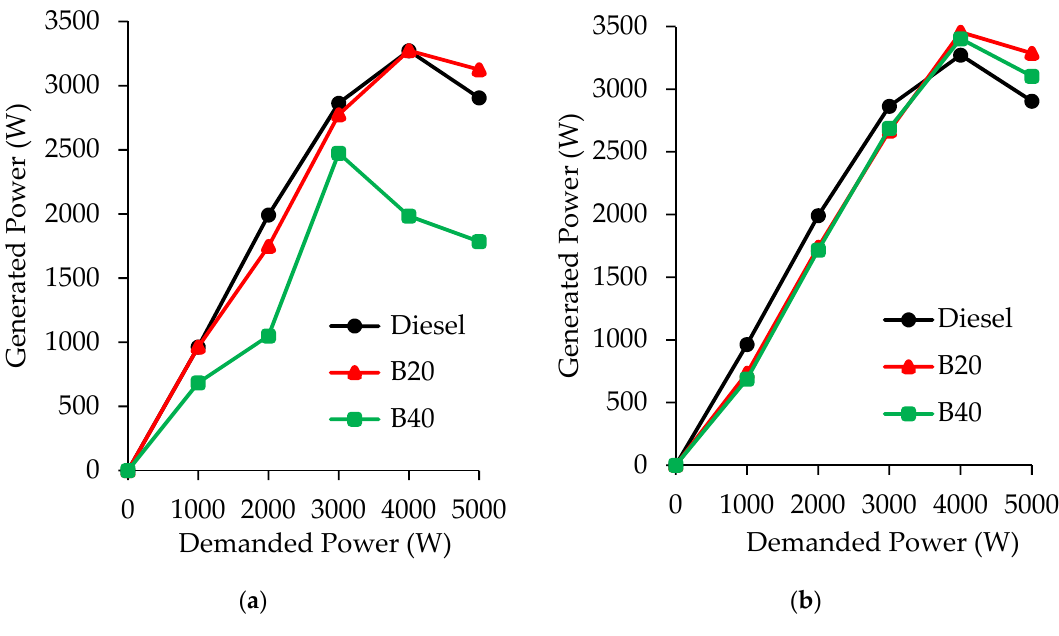
Figure 2. Generated power (W) at different demanded power values (1–5 kW) for: ( a ) diesel / acetone / sunflower oil; ( b ) diesel / acetone / castor oil blends. The errors in measurements are less than 3%.